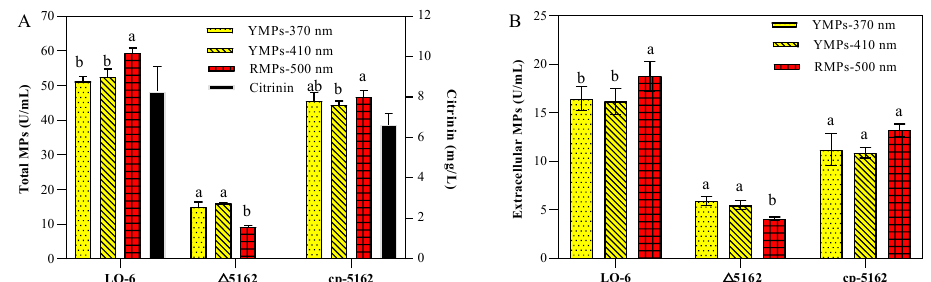
Figure 4. The total Monascus pigments and citrinin production ( A ), and extracellular Monascus pigments production ( B ) by the parent strain M. purpureus LQ-6 and recombination strains in submerged fermentation for 10 days at 30 ◦ C and agitated at 150 rpm in the dark. Different letters (a and b) up the columns in the group of same strain are considered statistically different ( p < 0.05), but the columns marked a or b to ab are considered insignificant difference.